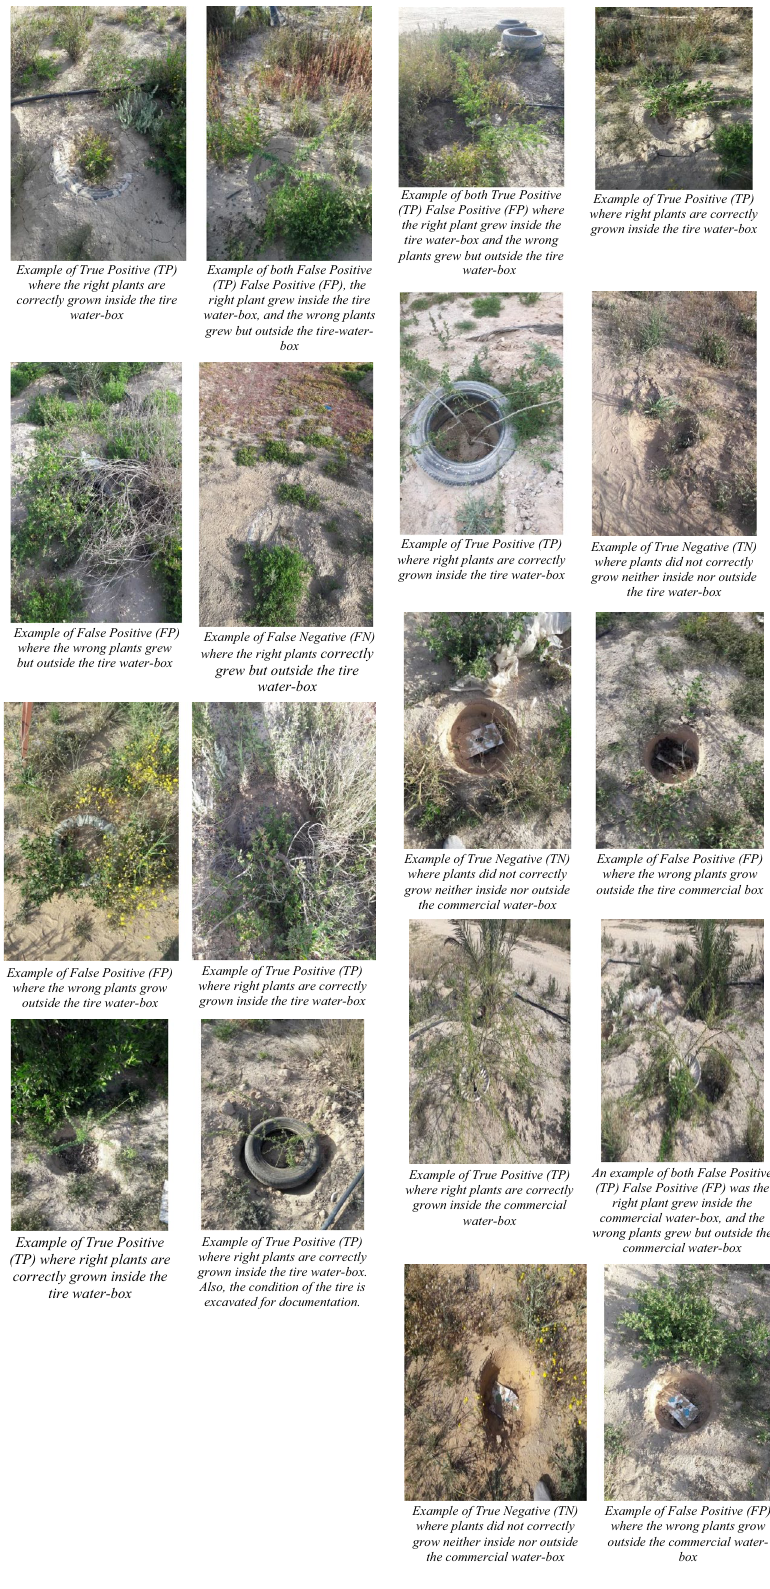
Figure 9. Examples of different scenarios of both